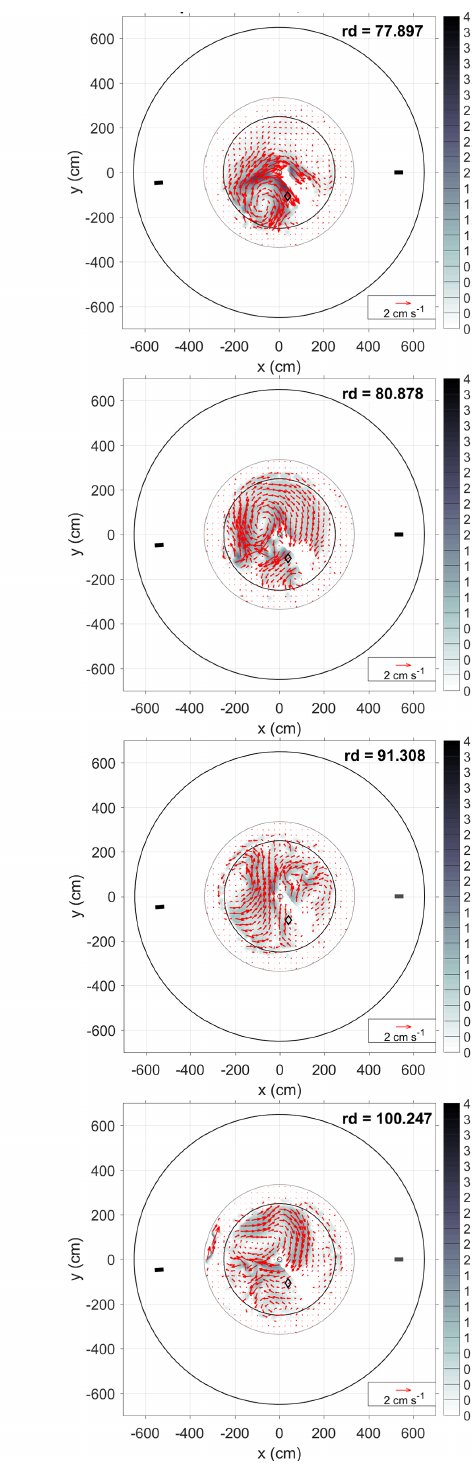
Figure B2. Evolution of the flow field in the lower layer of the rotating tank (represented by level 11) during EXP 27. The rotation days (rd) are indicated inside each panel. The diamond shows the location of the conductivity probe Cp3, and the two bars show the location of the two dense-water sources. The outer and inner bold circles delimit the tank edge and the central deep area, respectively. The gray circle delimits the extension of level